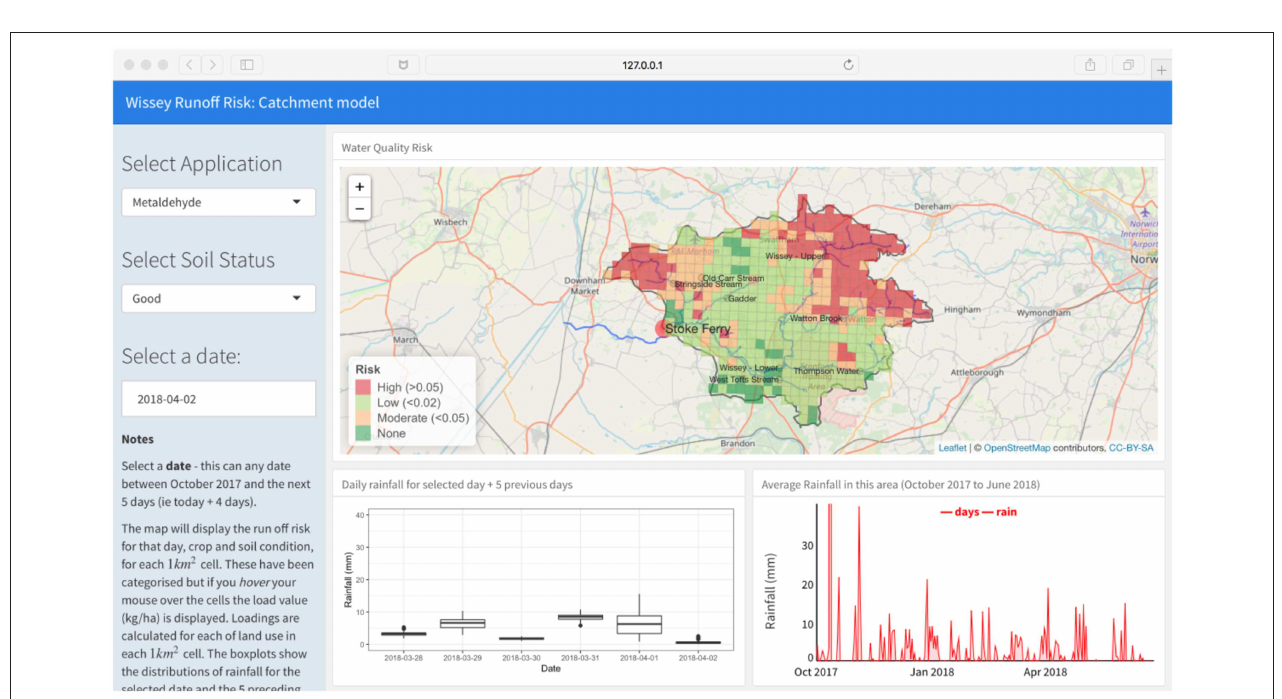
FIGURE 3 | A screenshot of output from the Teifi catchment field scale runoff risk model at https://github.com/lexcomber/saric.